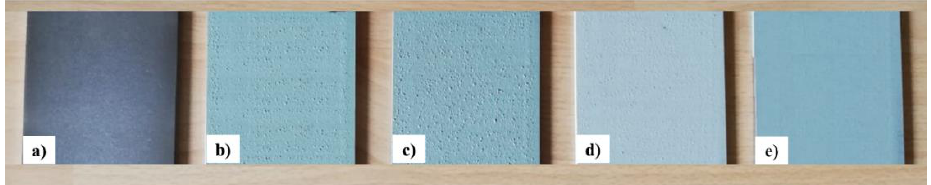
Figure 3. Photography of ( a ) bare metal and anti-corrosion systems of: ( b ) PANI/AR, ( c ) SiO 2 - PANI/AR, ( d ) CeO 2 -PANI/AR, and ( e ) TiO 2 A-PANI/AR.